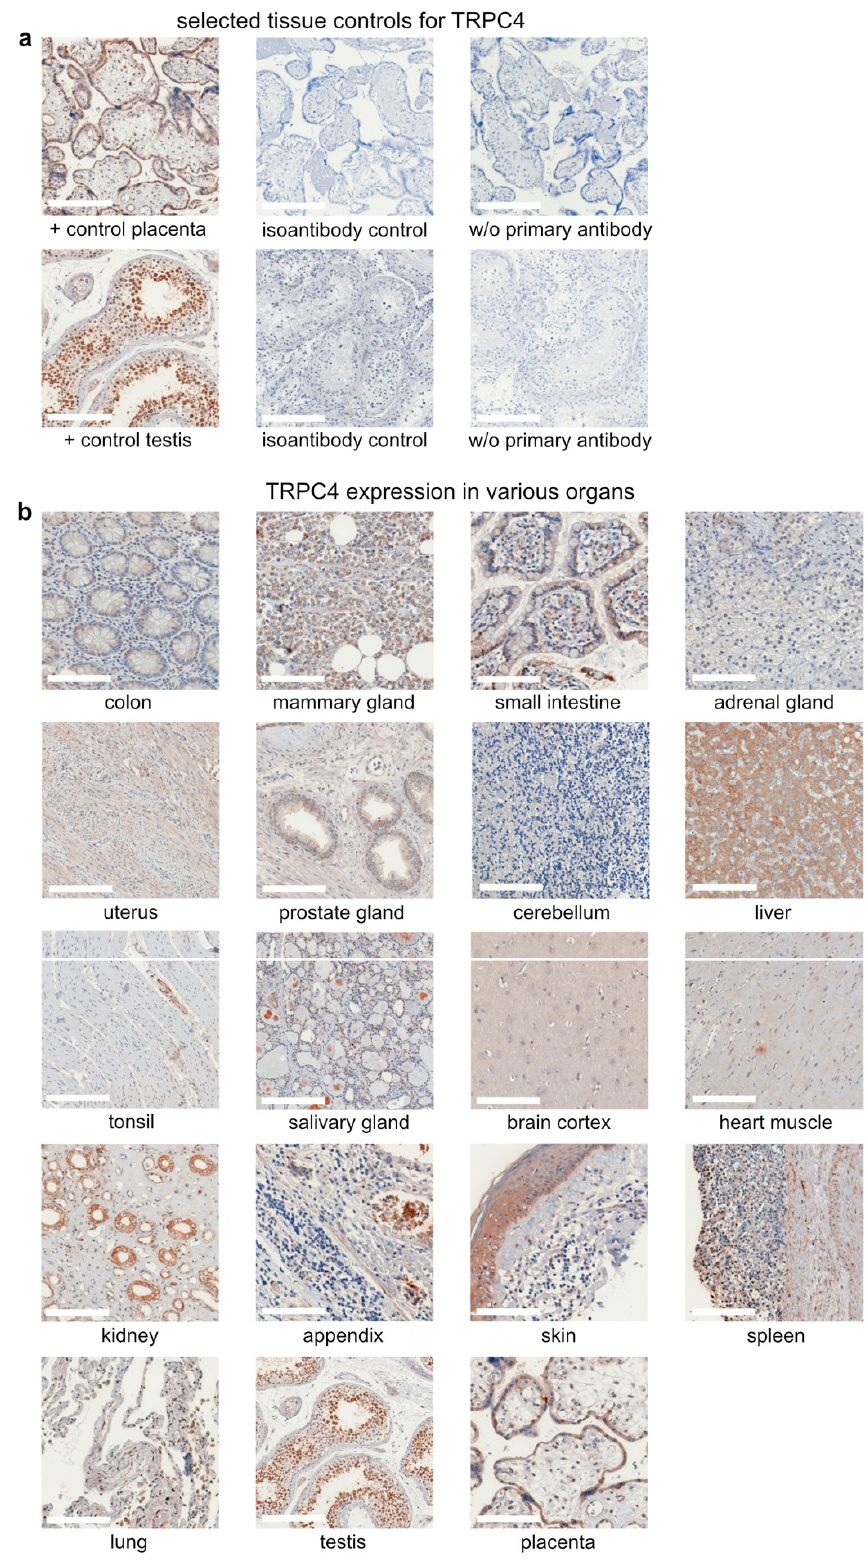
Figure 1. Tissue Controls for the Immunohistochemical staining of TRPC4. Scale bars represent 200 µm. ( a ) placenta und testis were used as positive controls for TRPC4 and showed no staining in relation to isoantibody control and without primary antibody. ( b ) TRPC4 expression in various organs.